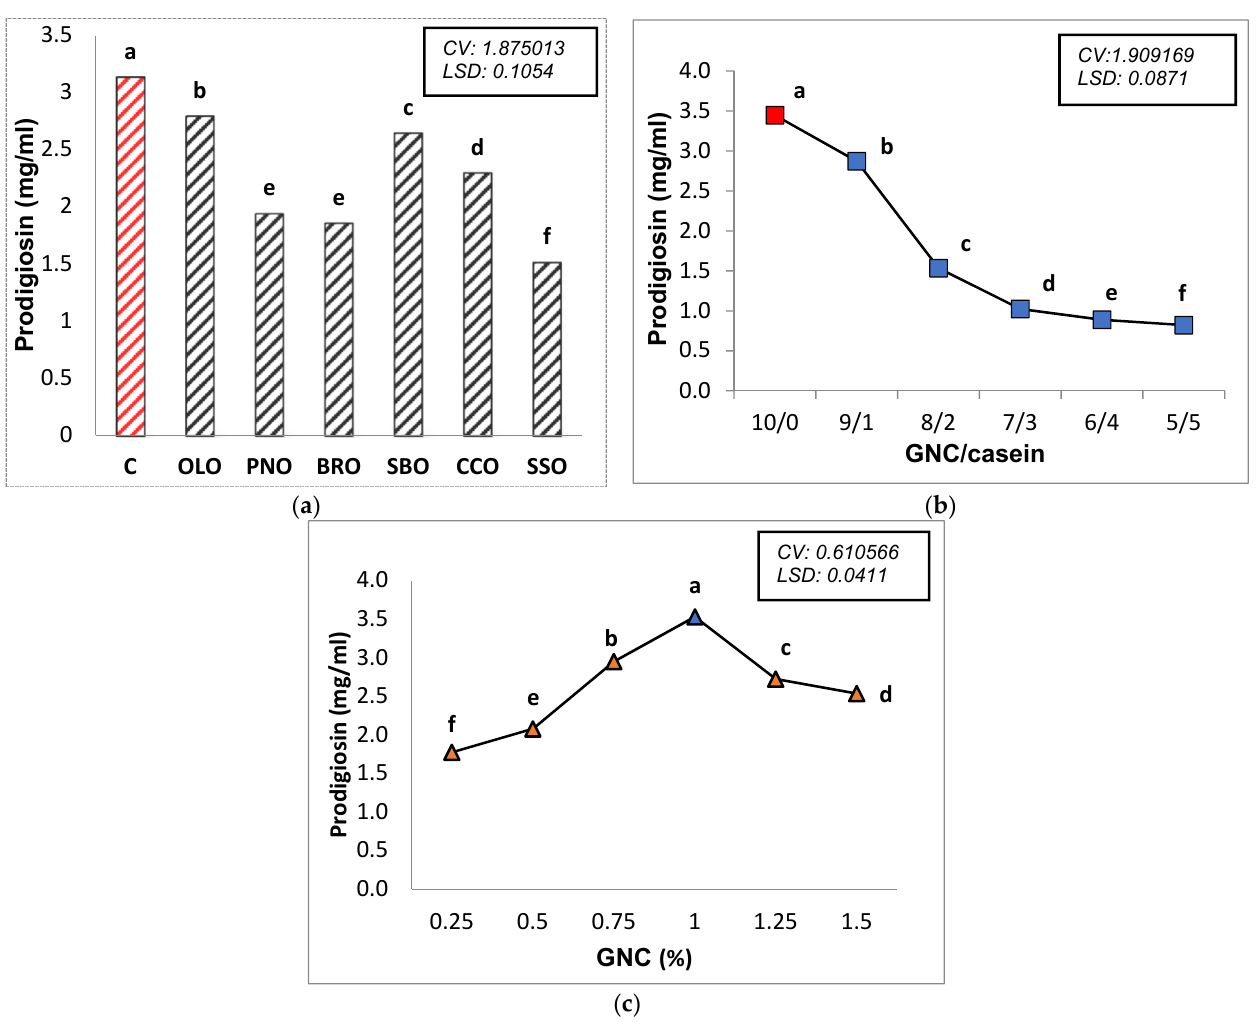
Figure 4. The influence of the culture medium ingredients on prodigiosin production from S. marcescens TNU02. Effect of supplements added to the medium. ( a ) Vegetable Oils, including olive oil (OLO), groundnut oil (PNO), brown rice oil (BRO), soybean oil (SBO), coconut oil (CCO), and sesame oil (SSO); ( b ) Casein ratio; ( c ) Substrate concentration. The graph was constructed by Microsoft Excel 2010. All of these experiments were conducted in triplicate and data were analyzed via the simple variance (ANOVA) then Duncan’s multiple range tests at p = 0.01 were performed. Values in the same figure with the different letters are significantly different. LSD—Least Significant Difference; CV—Coefficient of Variation.